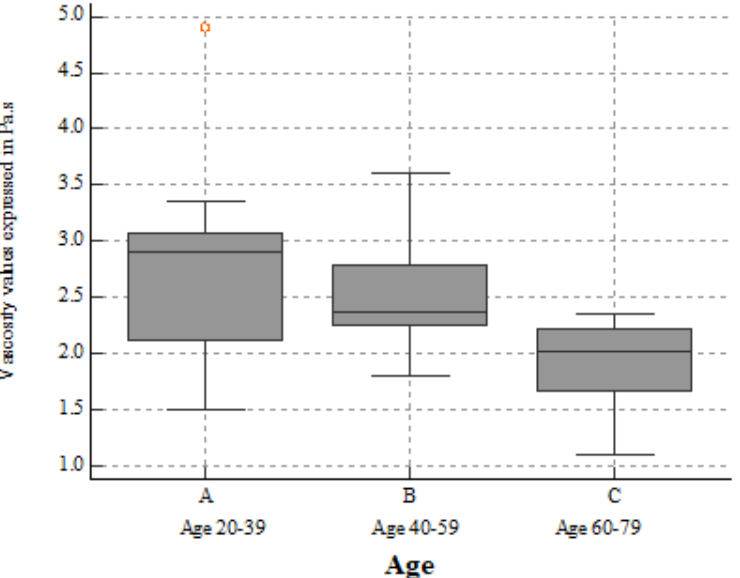
Figure 5. Box-and-whisker distribution plots showing Vi PLUS values across three different age subgroups. Vi PLUS values decreased slightly with age progression.